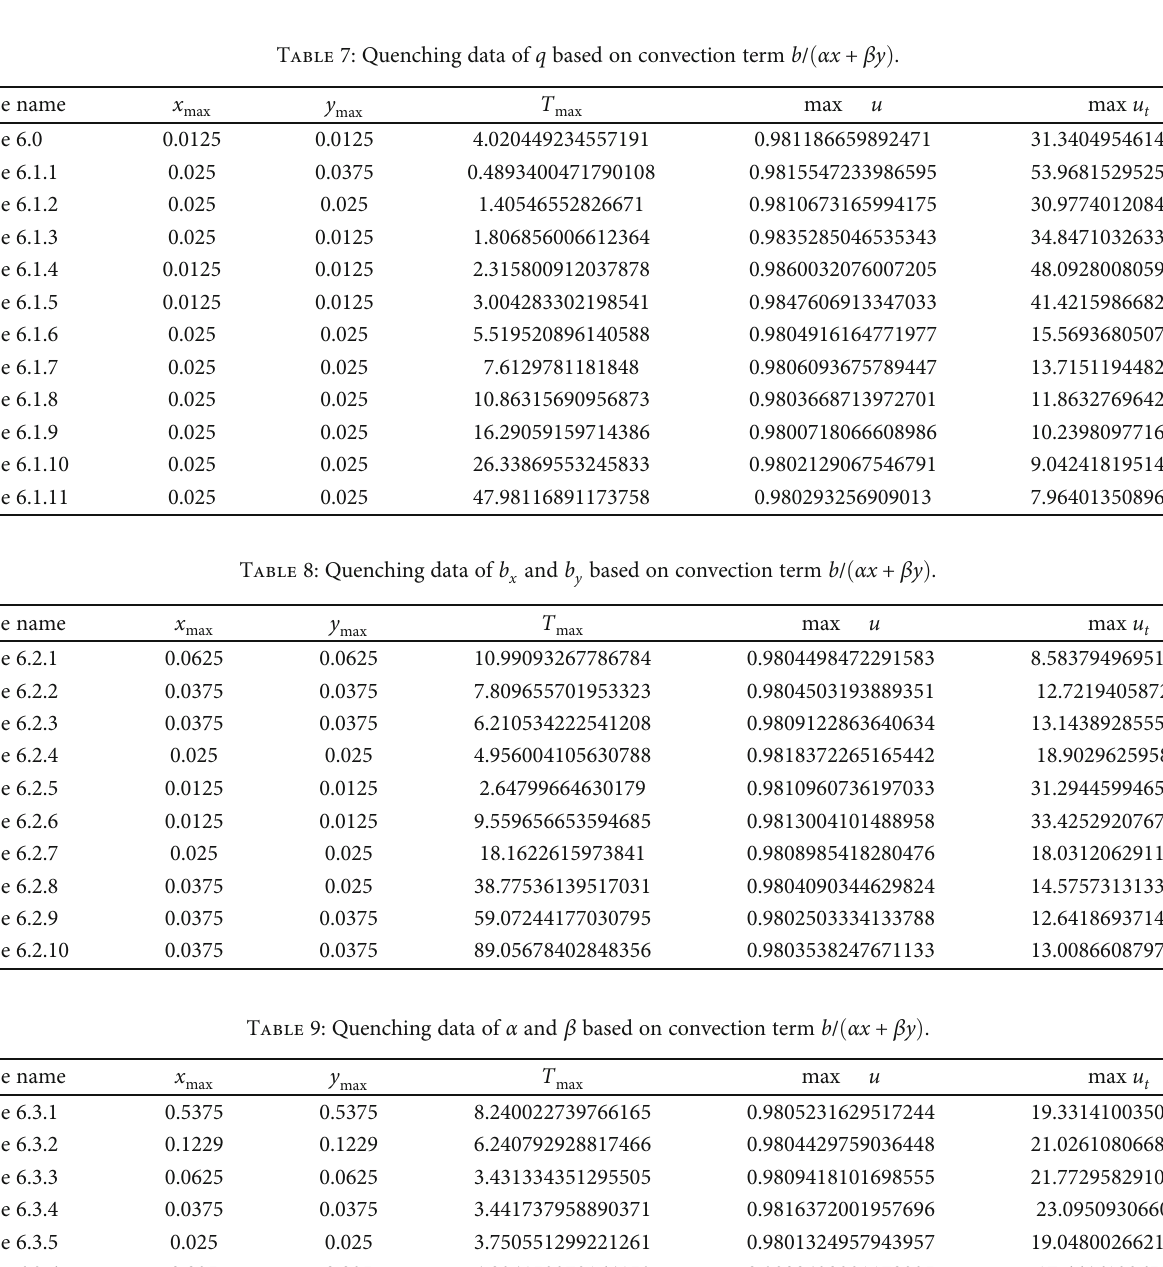
Table 7: Quenching data of q based on convection term b / ð α x + β y Þ .